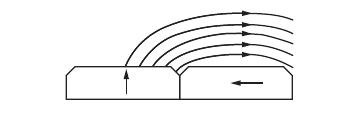
Figure 3: The CPMS of the Halbach array.